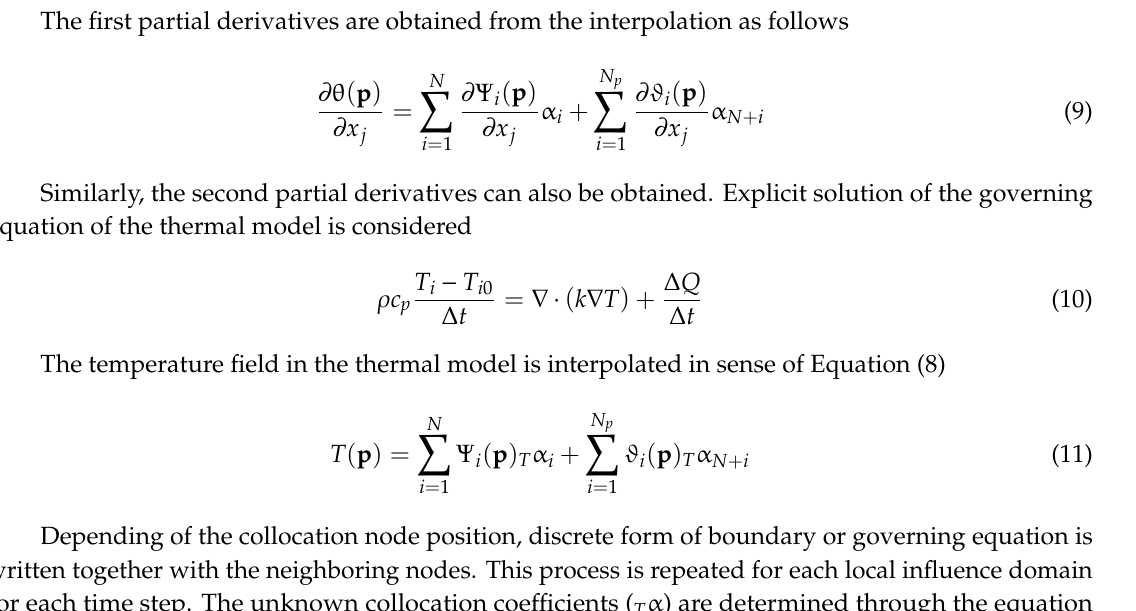
Figure 3. Domain and boundary discretization example with local influence domains consisting of five or seven nodes.